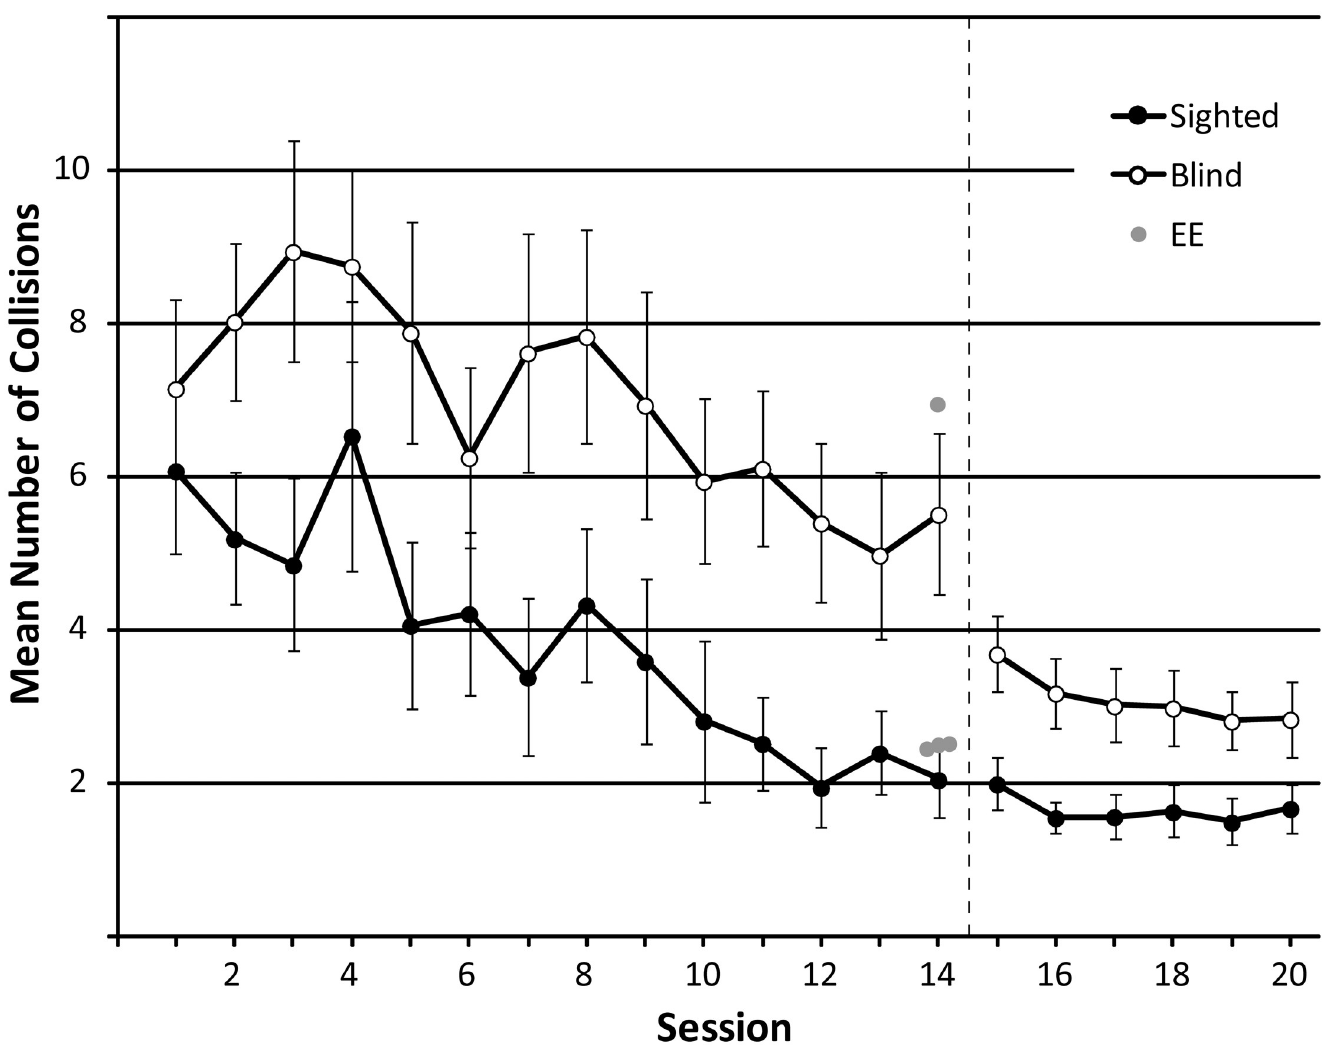
Fig 9. The mean number of collisions made in sessions 1–20. In session 15, unpredictable starting orientations were introduced, along with a 15 s timeout when a collision occurred. This is represented by the dashed black line. Data from SCs and BCs are shown as black and white circles, respectively with each symbol representing the average and error bars representing the standard error of the mean across participants. Data from experts (n = 4) who completed only a single session without training are shown as grey circles. For comparison, they have been plotted at session 14.